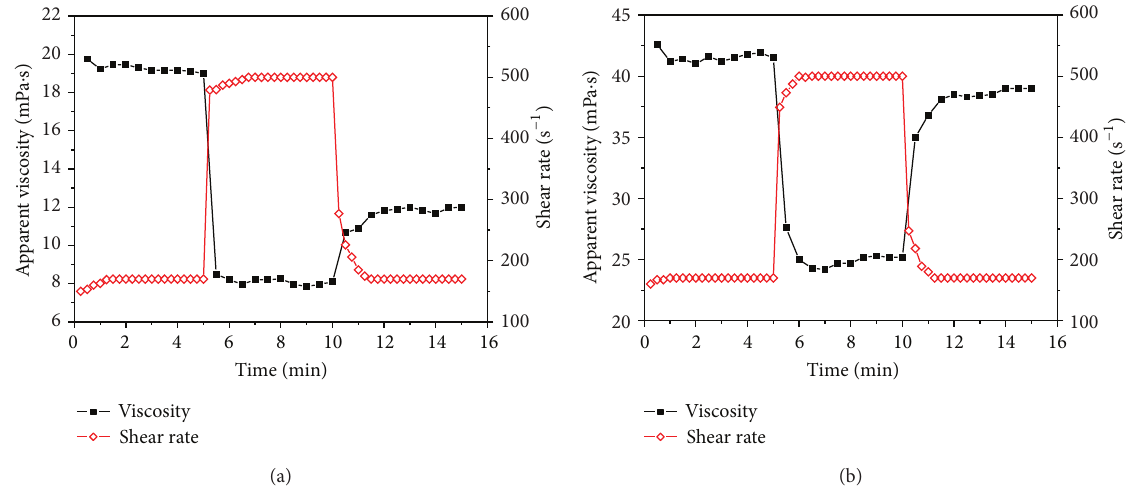
Figure 10: Shear-resistance of HPAM (a) and hyperbranched polymer (b) at 80 ∘ C (5000